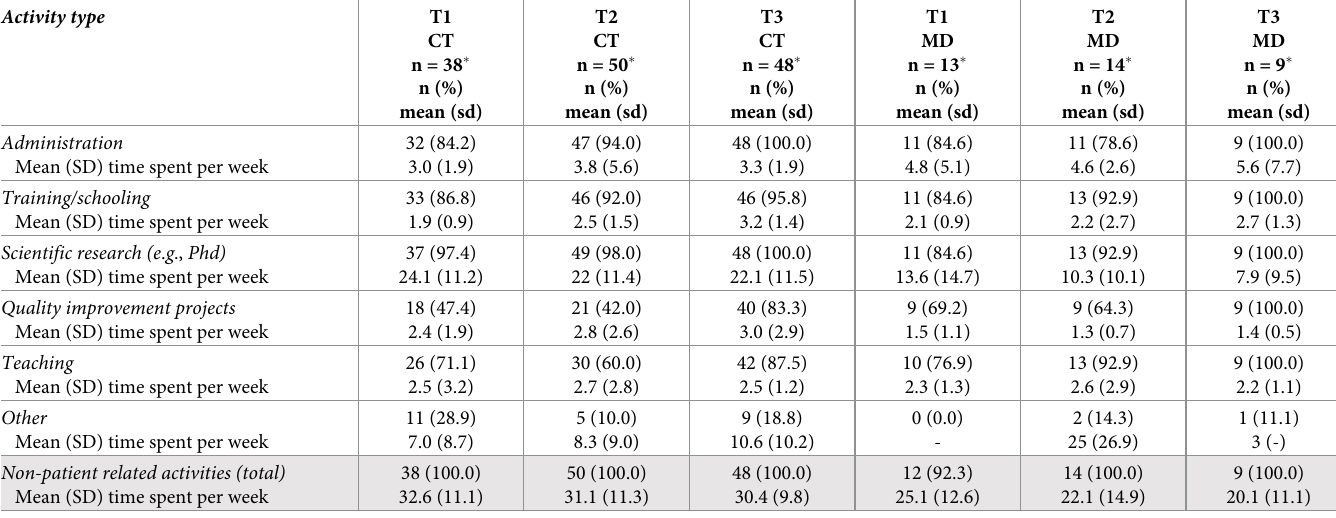
Table 5. Mean time spent on non-patient related